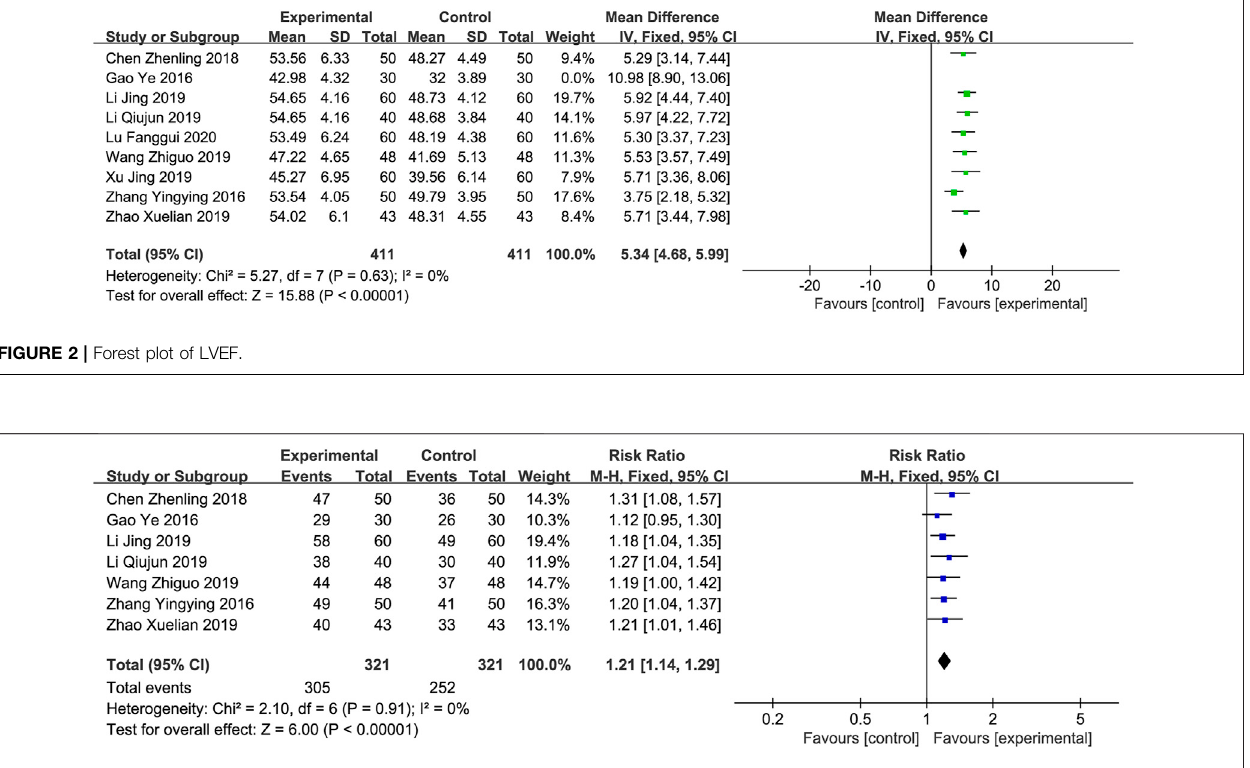
FIGURE 3 | Forest plot of total effective